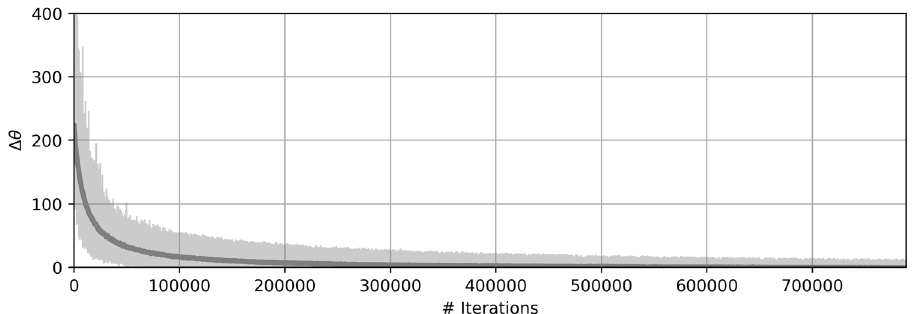
Figure 2. Biggest variation of consecutive θ values for each